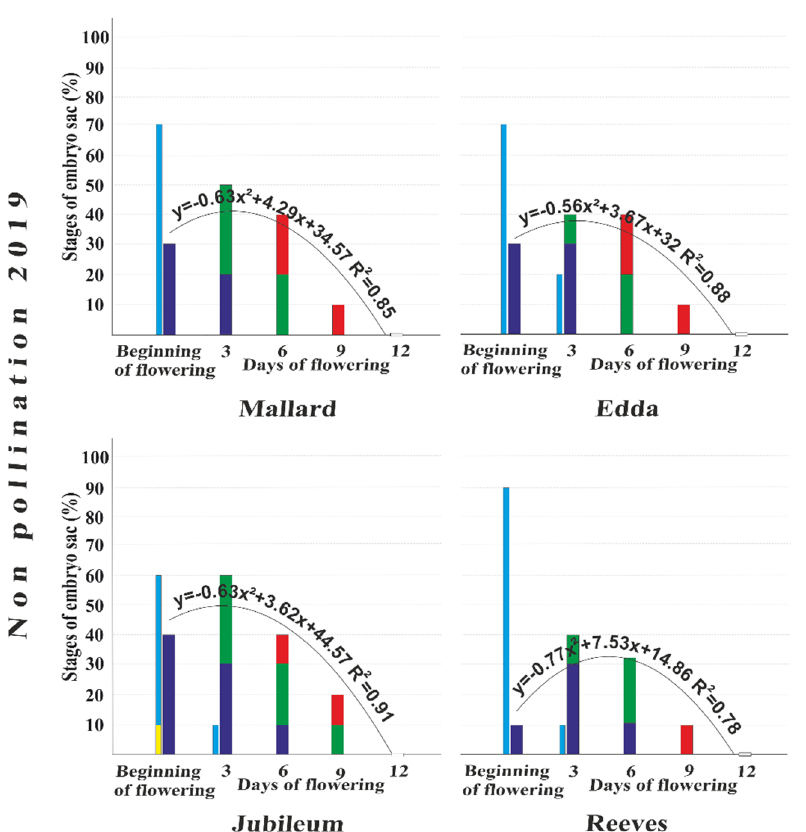
Figure 3. Regression analysis of embryo sac viability (%) in unpollinated flowers at the BOF, and on the 3rd, 6th, 9th, and 12th days after BOF in the plum cultivars ‘Mallard’, ‘Edda’, ‘Jubileum’, and ‘Reeves’ during 2018 and